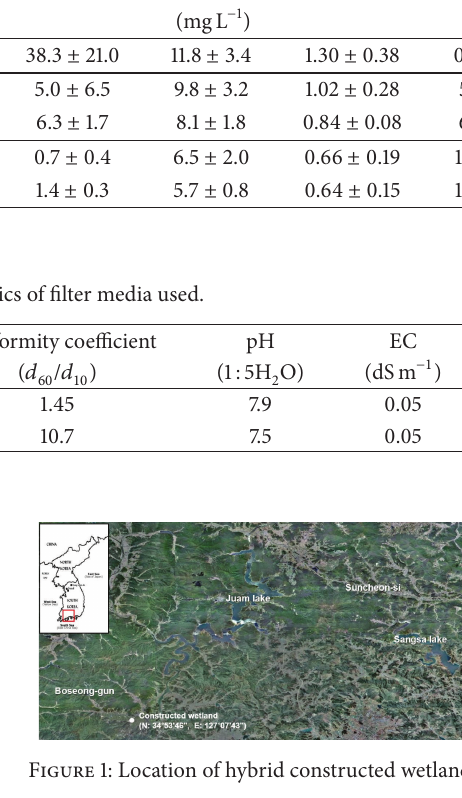
evaluated herein consisted of 2-stage CWs containing coarse sand (Figure 1). The beds consisted of vertical flow (VF; aerobic conditions) and horizontal flow (HF; anaerobic conditions) and are shown in Figure 1. The VF-HF